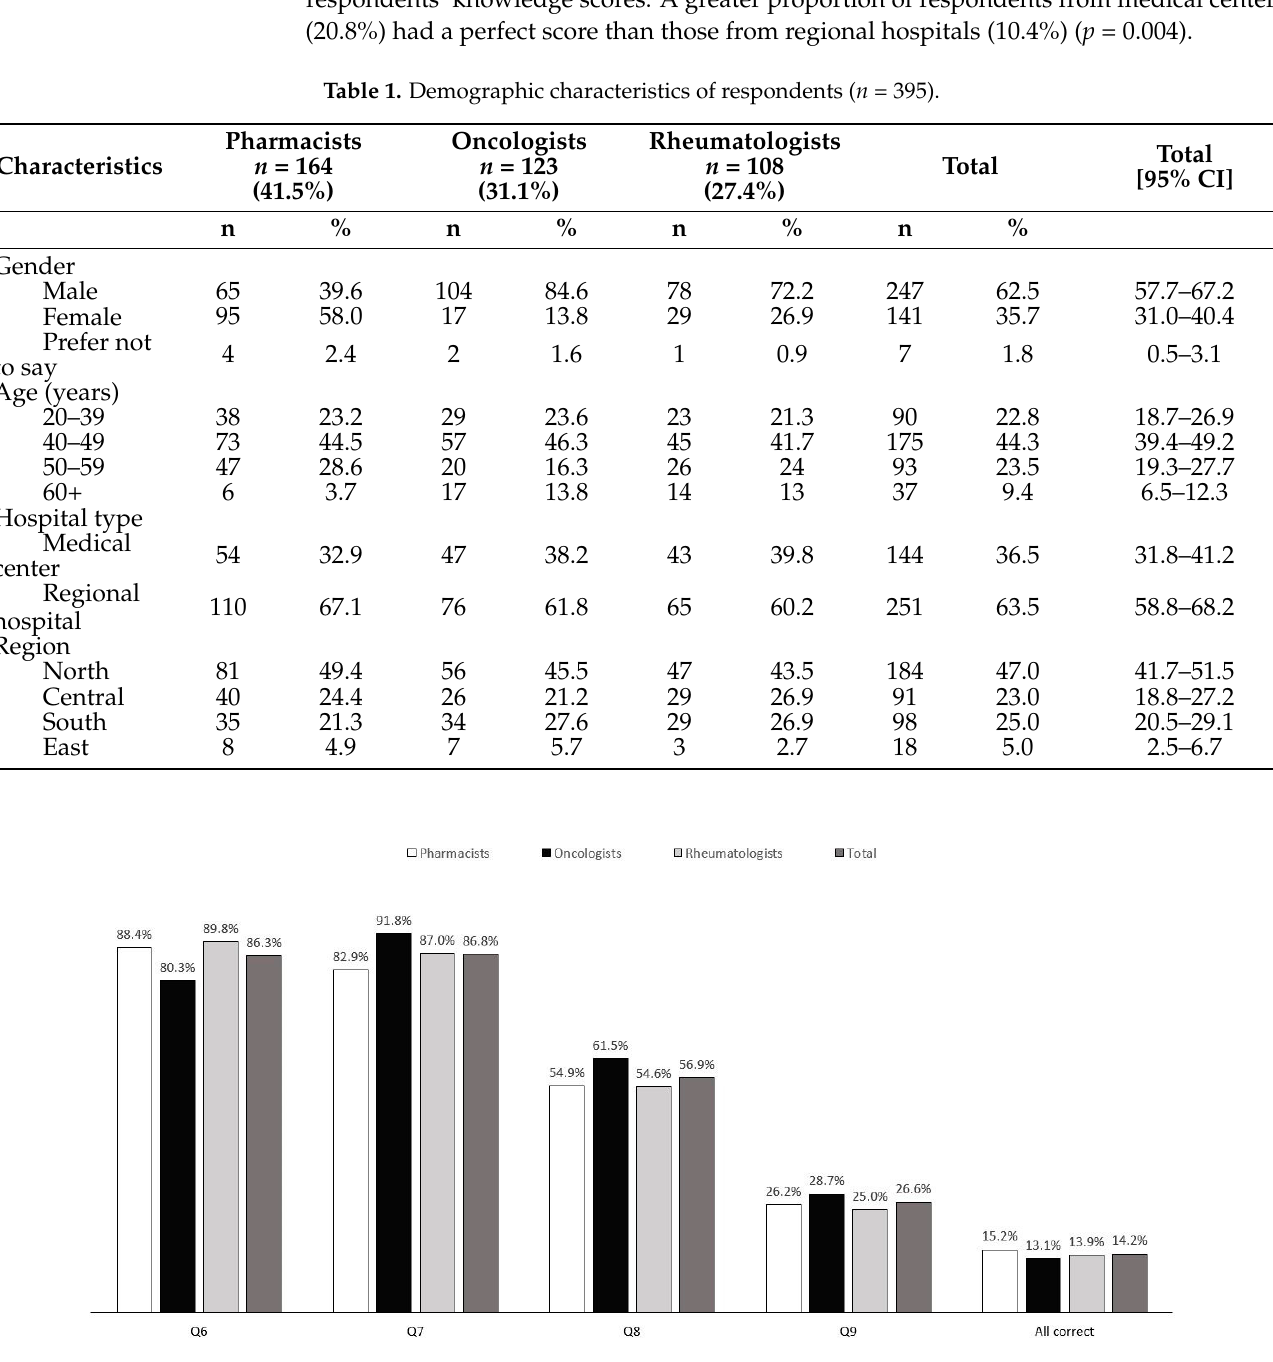
Figure 1. The proportion of respondents (%) who correctly answered knowledge questions